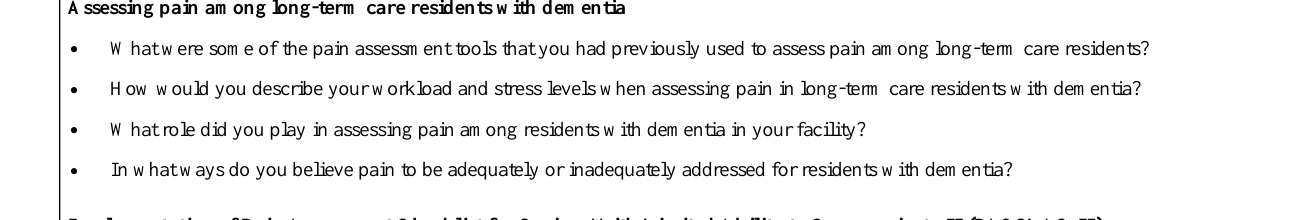
Textbox 1. Moderator guide for interviews with frontline staff. Assessing pain among long-term care residents with